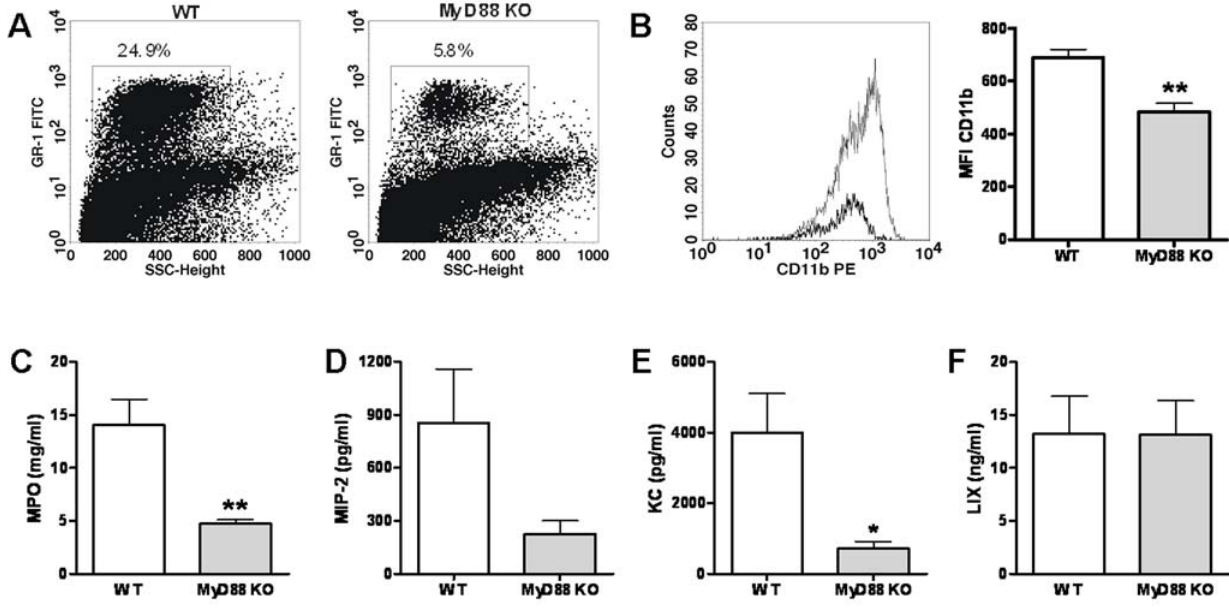
Figure 8. MyD88 plays an important role in early neutrophil recruitment after infection with B.pseudomallei . The impact of MyD88 deficiency on early neutrophil recruitment was investigated by analysing the amount of neutrophils in the pulmonary compartment using FACS analysis (see Methods) 24 h after intranasal inoculation of WT and MyD88 KO mice with 5 6 10 2 CFU B. pseudomallei . MyD88 KO mice displayed significantly fewer neutrophils in their lungs compared with WT mice (the percentages of neutrophils of the total pulmonary cell count are given from one respresentative WT and one respresentative MyD KO mouse) (A) . Additionally, MyD88 deficient neutrophils (gray line and gray bars) present at t=24 expressed less CD11b on their surface compared to WT neutrophils (black line and white bars): representative histograms show decreased CD11b expression on pulmonary neutrophils (B) . This corresponded with lower MPO levels in lung homogenates of MyD88 KO mice (gray bars) compared to controls (white bars) (C) . In line, pulmonary MIP-2 (D) and KC (E) levels tended to be lower or were significantly reduced in MyD88 KO mice. LIX levels were unaltered in MyD88 KO mice at this early time point (F) . SSC, side scatter; FITC: fluorescein isothiocyanate; PE, phycoerythrin; MFI, mean fluorescence intensity; MPO, Myeloperoxidase; MIP-2: macrophage-inflammatory protein-2; LIX, lipopolysaccharide-induced CXC chemokine. Bar figures represent mean 6 SEM; n=6–8 per mouse strain. * P , 0.05; ** P , 0.01.